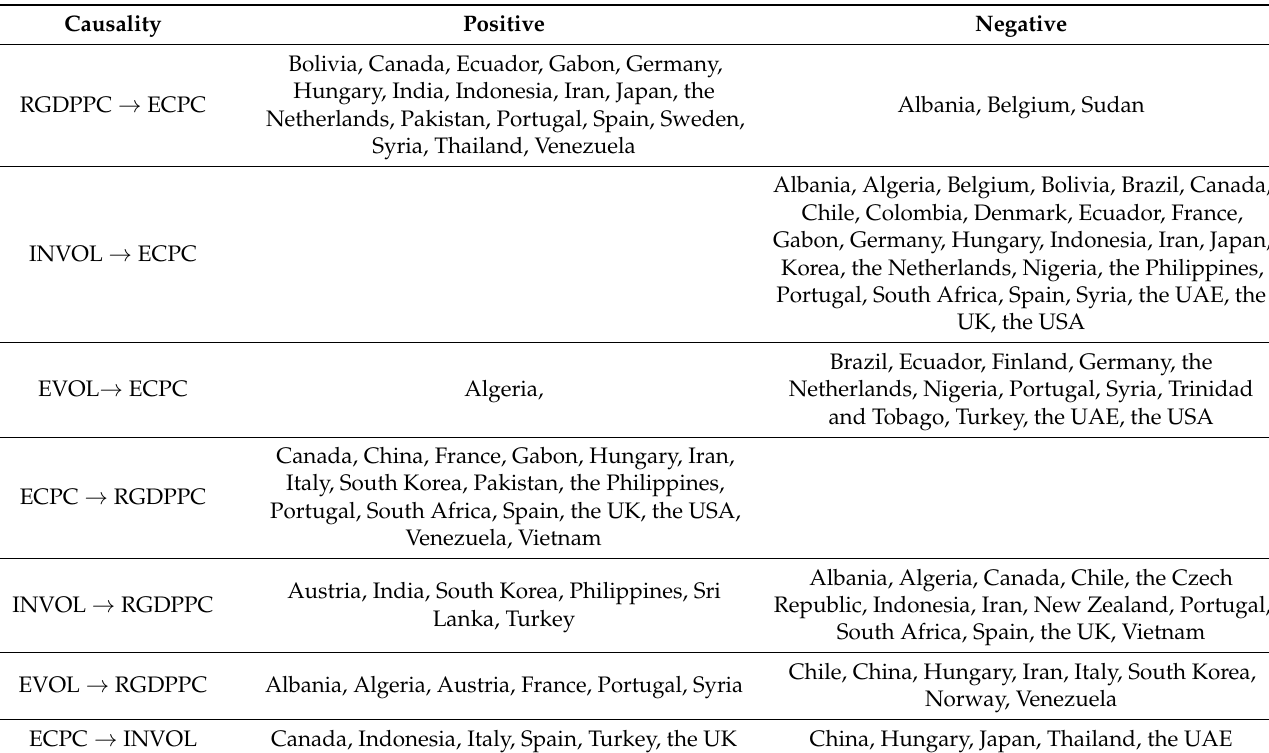
Table 4. Short-run Granger causality